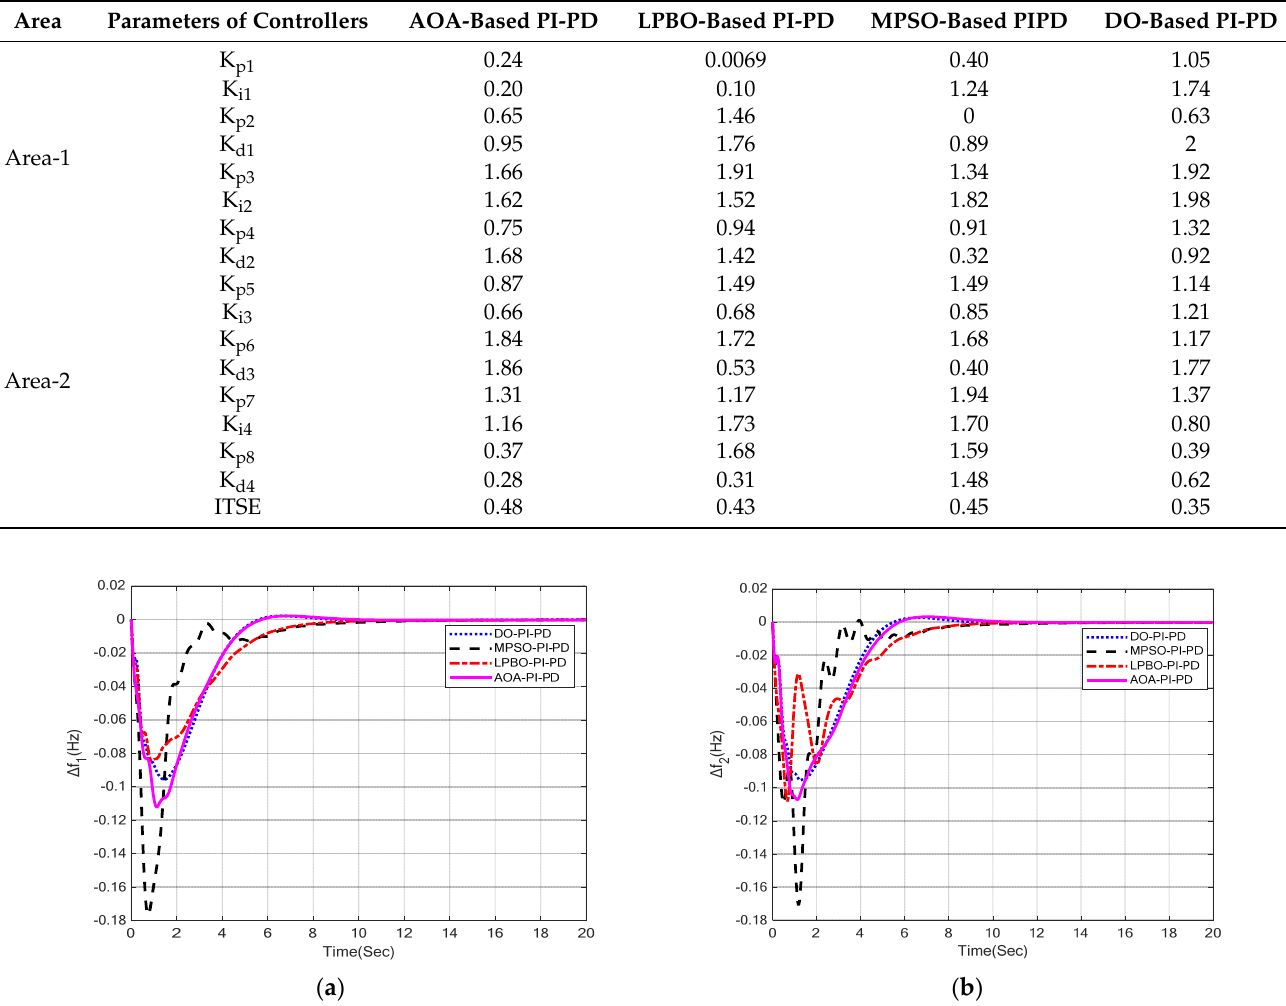
Figure 11. LFC responses in a two-area multi-source realistic IPS with nonlinearities. ( a ) ∆ f 1 ; ( b ) ∆ f 2 . Table 9. Numerical results of LFC in a two-area multi-source realistic IPS with nonlinearities. Area-1